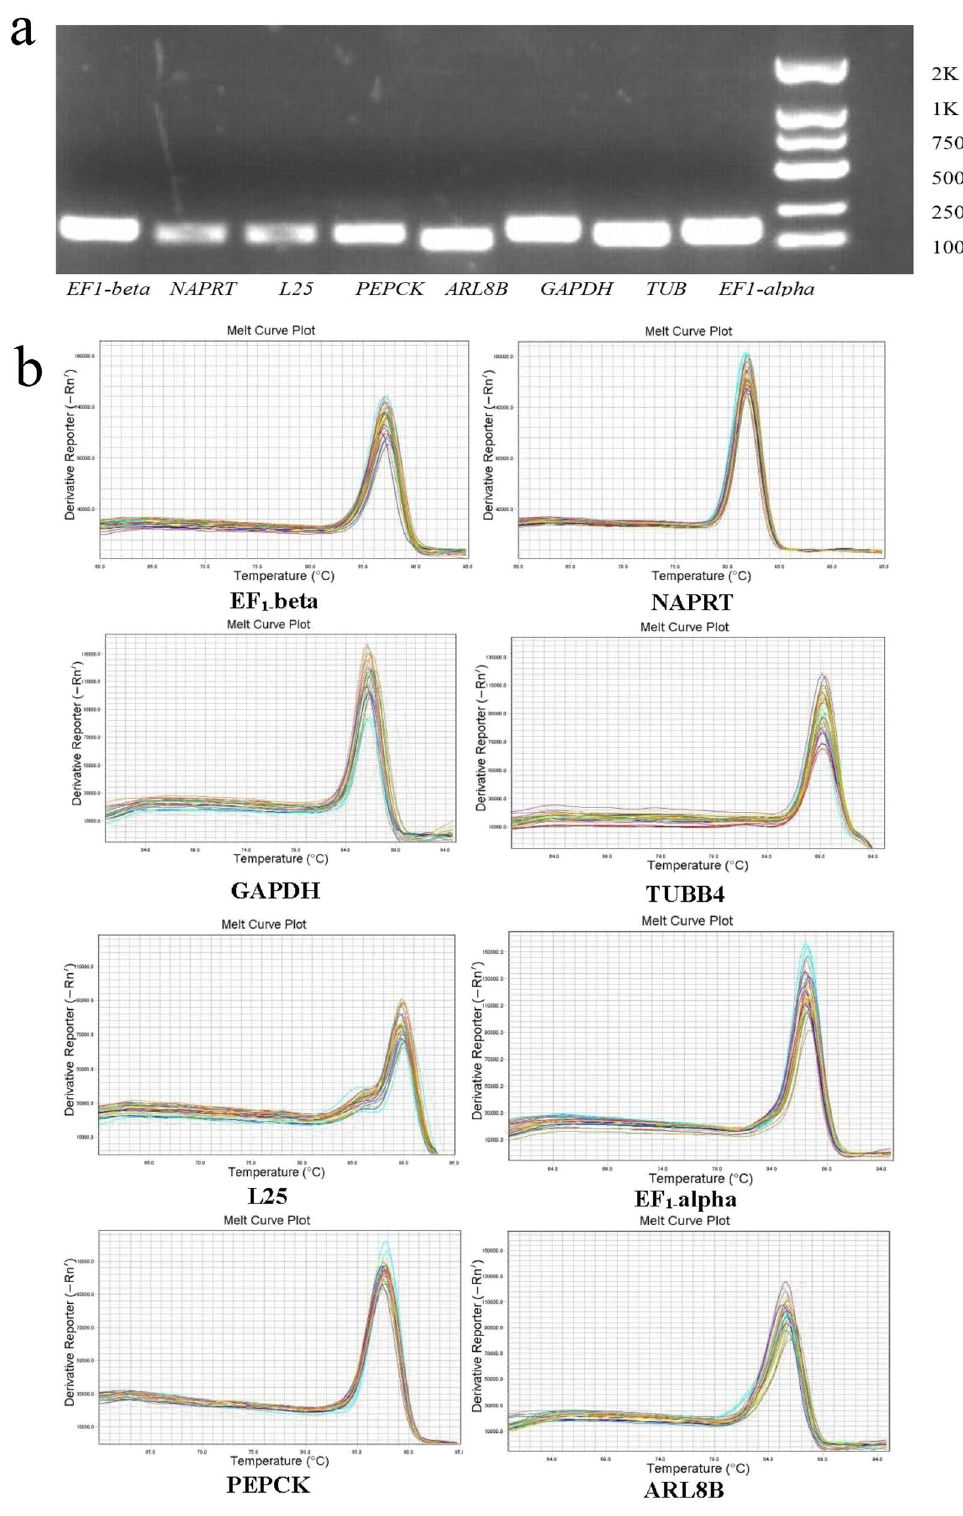
Figure 2. Specificity of qRT-PCR amplification. ( a ) Agarose gel (1%) showing amplification of a single product of expected size for each candidate reference gene. ( b ) Melt curves of eight candidate reference